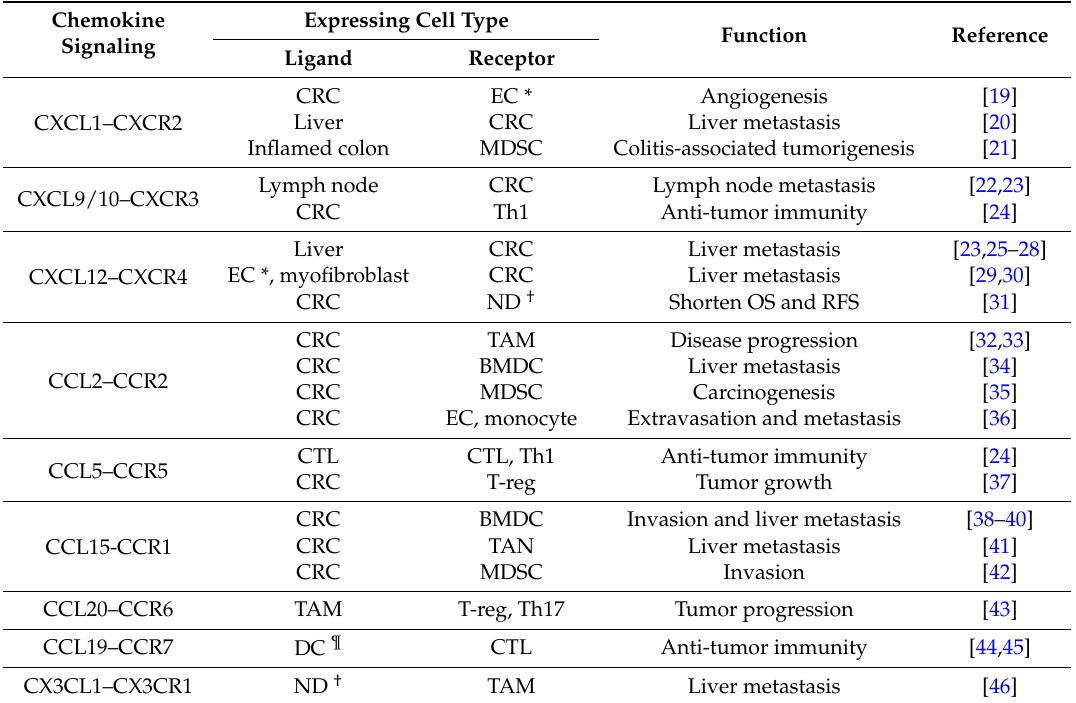
Table 1. Chemokine signaling reported to be involved in colorectal cancer (CRC) progression through interaction with